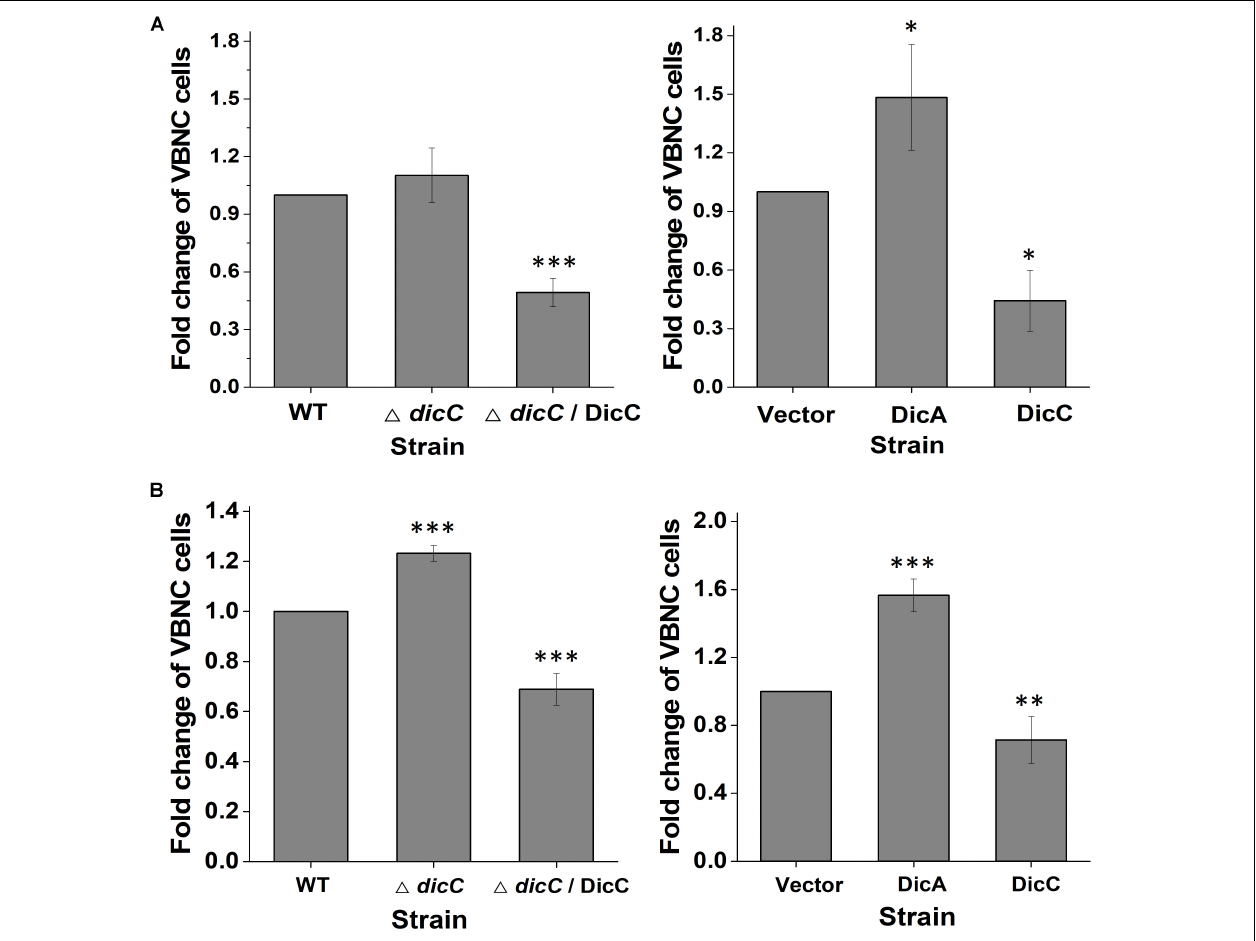
FIGURE 5 | Effects of DicC and DicA on the ability of E. coli O157:H7 to form the VBNC state under acid stress (A) and H 2 O 2 stress (B). (A) Changes in the VBNC cell percentage in the WT, (cid:49) dicC mutant, (cid:49) dicC /DicC, vector, DicC strain and DicA strains under pH 2.5 sodium chloride. (B) Changes in the VBNC cell percentage in the WT, (cid:49) dicC mutant, and (cid:49) dicC /DicC, vector, DicC and DicA strains under 50 mM H 2 O 2 . Error bars show the standard errors of the means. Significance was calculated by the t -test ( ∗ p < 0.05, ∗∗ p < 0.01, ∗∗∗ p <